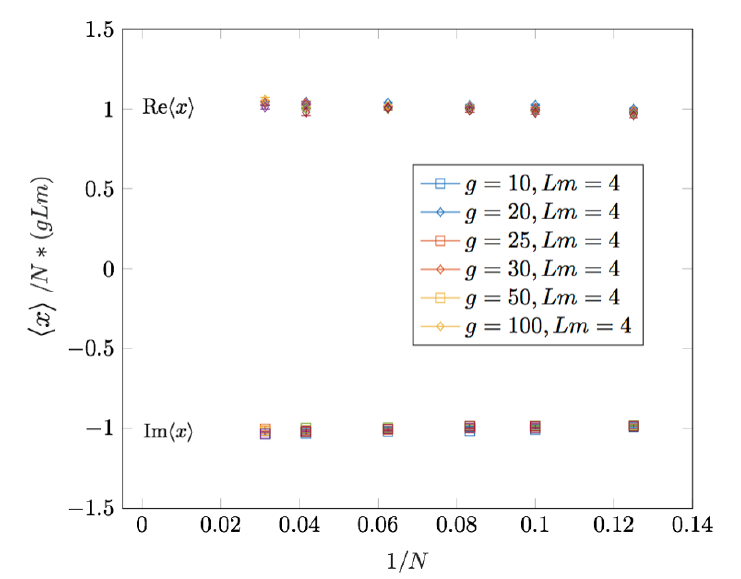
Figure 3 . Plot of the real and imaginary part of expectation value is normalized by N= ( gLm ), namely the perturbation theory result (B.10) at (1 =g ), and therefore the constant behavior visible in the (cid:13)atness shows for O is linear in N